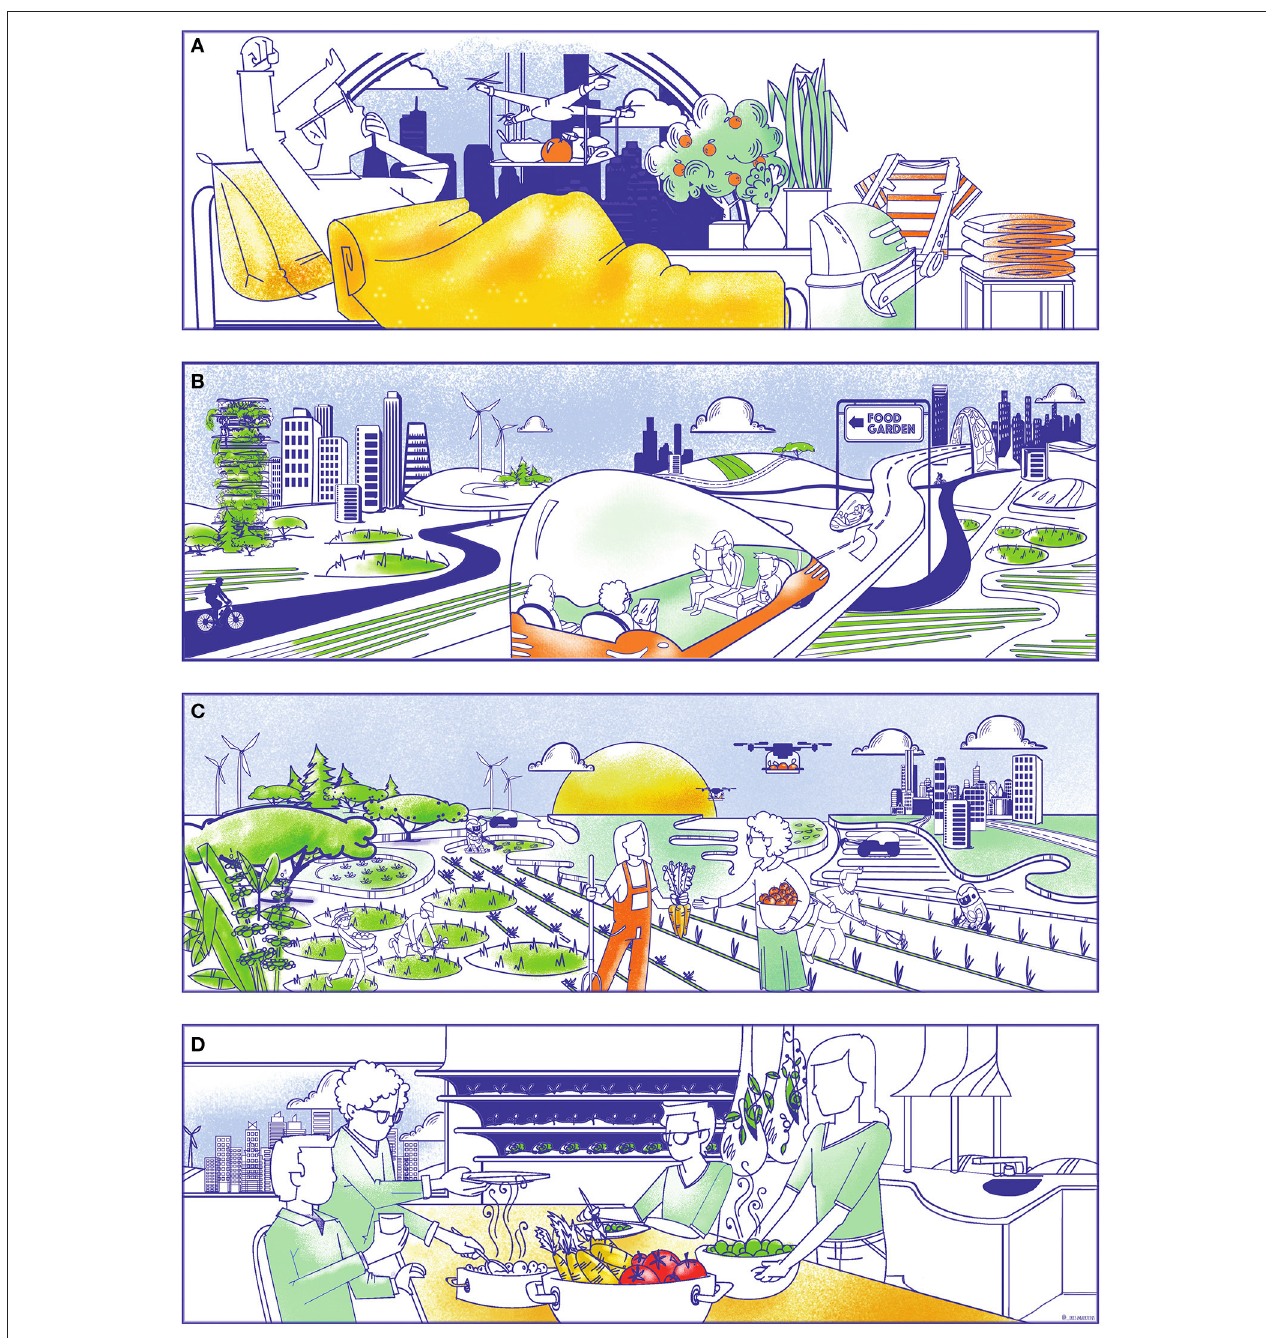
FIGURE 2 | A day in a Eudaimonian food system (from top to bottom). (A) : 9a.m.: Given greatly reduced or even non-existing working hours since the introduction of UBI, the need for alarm clocks has been greatly reduced. Many household chores have also been automated, leaving citizens with more spare time. (B) : 11a.m.: Traveling to gardening spaces together with friends or community members in automated vehicles. The transition to automated vehicles has also opened up parking spaces for gardening, restaurant terraces, bicycle lanes, and other activities. (C) : 4 p.m.: After half a day’s work in the community garden, the daily harvest is shared and discussed. Labor-intensive and redundant tasks have been automated, to leave the most rewarding tasks to the gardener. Weeding and pest control have also become mechanized, further reducing our reliance on chemicals. (D) : 7 p.m.: The farm-to-plate concept is no longer a luxury of a few restaurants or rural citizens, but commonplace during dinner parties where crop varieties, farming practices, and preparation techniques are frequent topics for discussion. Seeds are commonly exchanged and plant sprouts prepared in the house. Time investments and simplified distribution chains have also resulted in a great reduction of food waste, where produce is selected for its flavor, not its productivity, nor its esthetics. Design by Iris Maertens (www.irisistible.design).